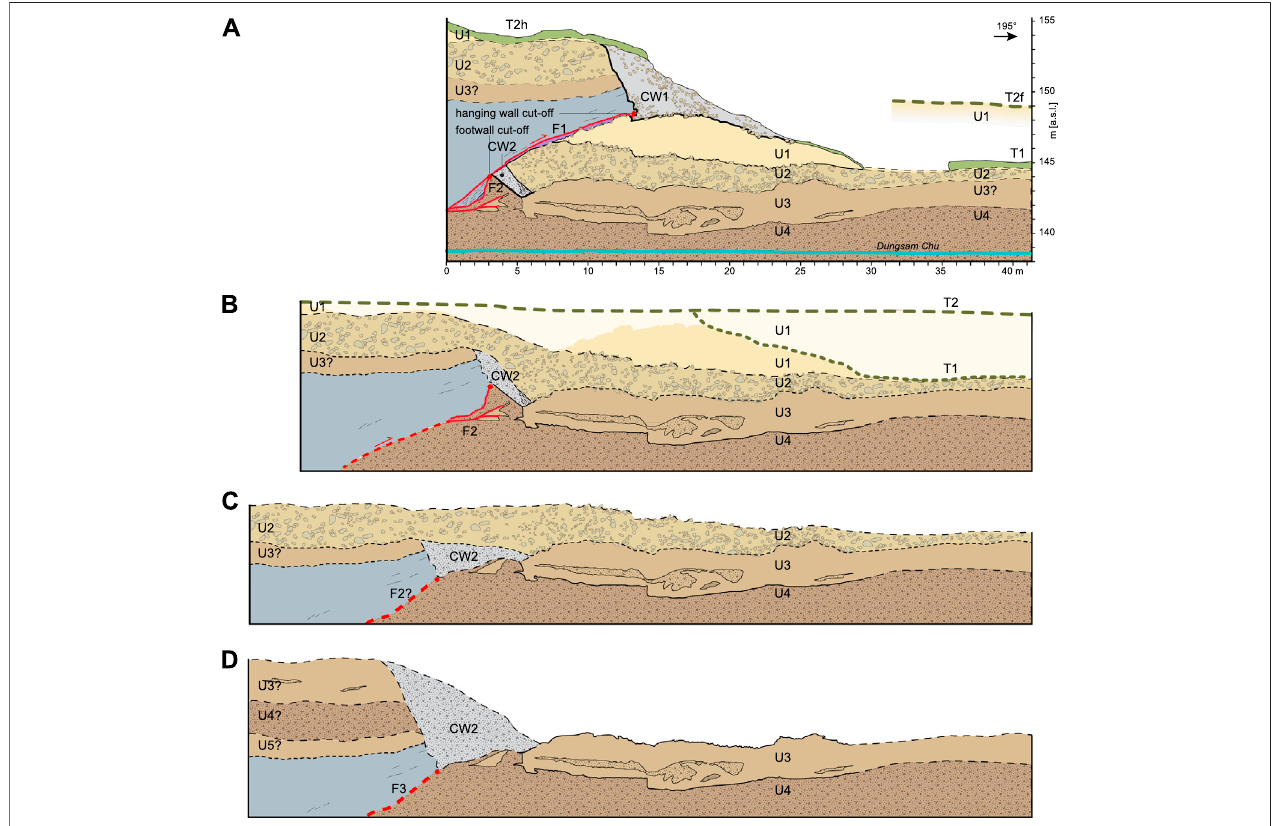
FIGURE 7 | Retrodeformed section. (A) Current situation. (B) Pre 1714, this is a conservative restoration in which the inferred cut-off lines ( Figure 4 ) were placed together. No other adjustments were made. Notice that the top of the hanging wall is restored to the same level as the current top of the terrace 2. Lateral variations of layerthicknessesareinterpretedasacommonfeatureofalluvialdepositsandtheresultoftheincisionofterrace1intoterrace2.NoticethesteepeningoftheF2,similarto the phenomenon observed by Le Roux-Mallouf et al. (2020). Indicated is the maximum northward extent of the cut in terrace T1. Tapering of U1 deposits is due eithertotheiroverlappinganolder fi ll-cutterraceormorelikelyaminordisplacementofU2byF2 (C) RetroderformedsectionattheendofthedepositionofU2,beforethe minor event F2. (D) Section after the event along the F3 and after the formation of the related colluvial wedge.